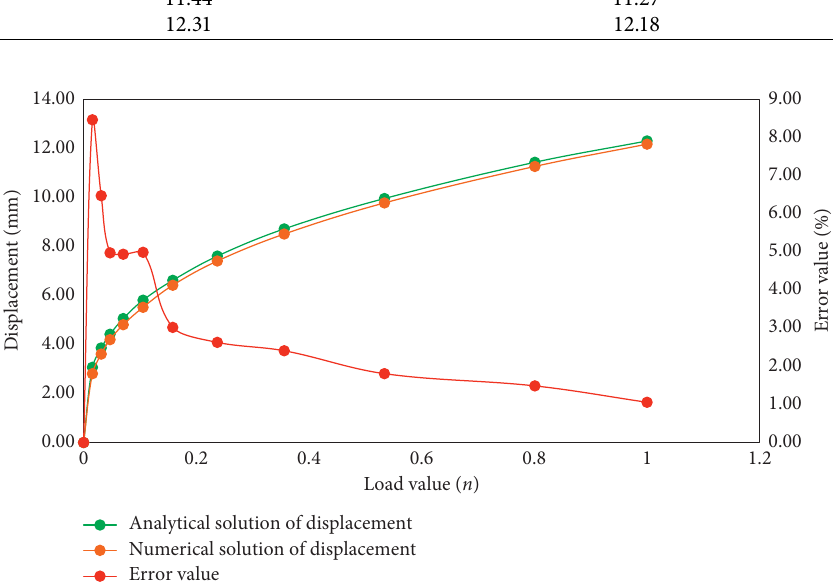
Figure 4: Load-displacement curve and error comparison diagram of single beam string element.